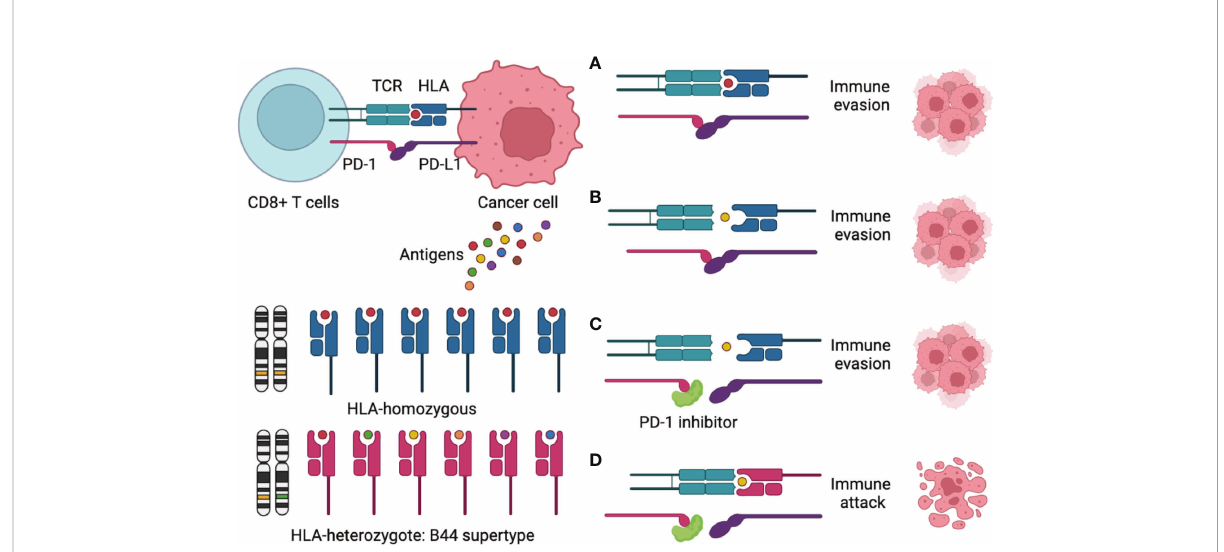
FIGURE 3 Schematic fi gure to explain the mechanism of the HLA-B44 supertype in fl uences cancer response to PD-1 inhibitors immunotherapy. (A) CD8+ T cells recognize a tumor-associated antigen through the HLA-I/T cell receptor (TCR) complex, but PD-L1 binding to PD-1, which promotes immune evasion; (B) CD8+ T cells could not recognize tumor-associated antigens through the HLA-I/TCR complex and PD-L1 binding to PD-1, which promotes immune evasion; (C) PD-1 inhibitors overcome immune evasions, but CD8+ T cells could not recognize tumor-associated antigens through the HLA-I/TCR complex, which promotes immune evasion; (D) CD8+ T cells recognize many tumor-associated antigens through the HLA — B44/TCR complex, meantime PD-1 inhibitors Inhibit PD-1/PD-L1 interaction, which promotes immune